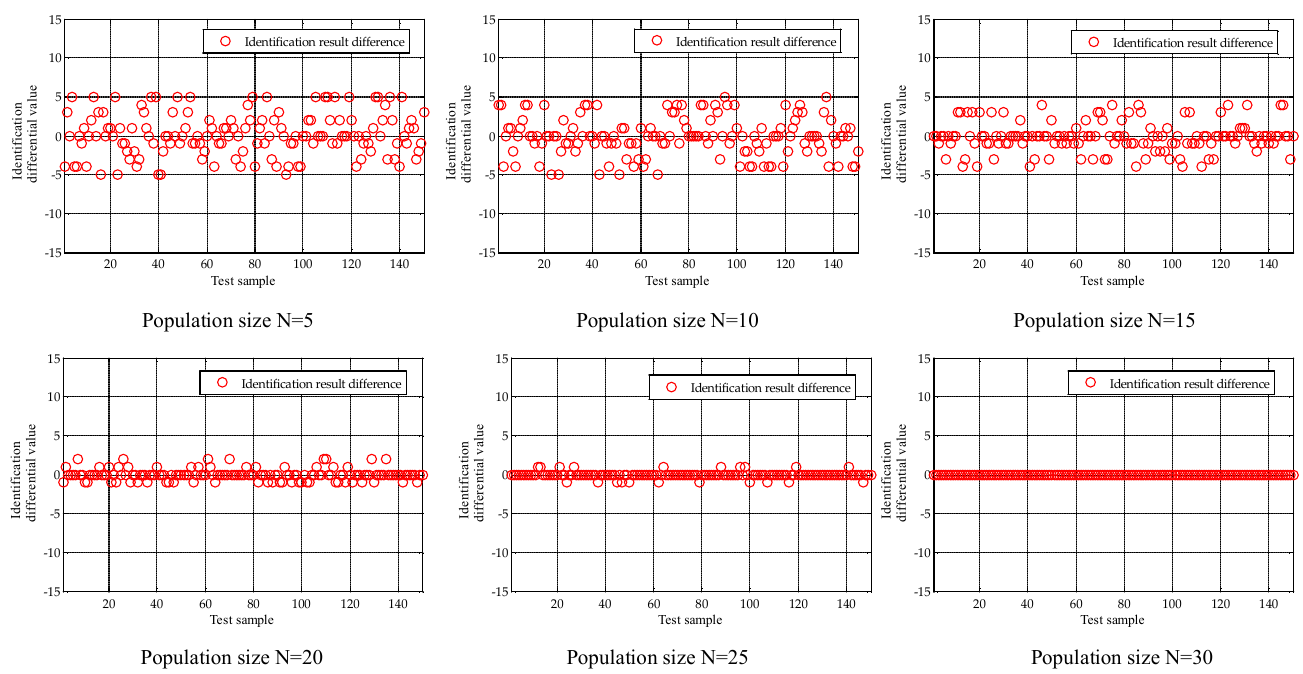
Figure 6. Influence of population size on identification error.